Question: Provide a publication-style caption for this figure.
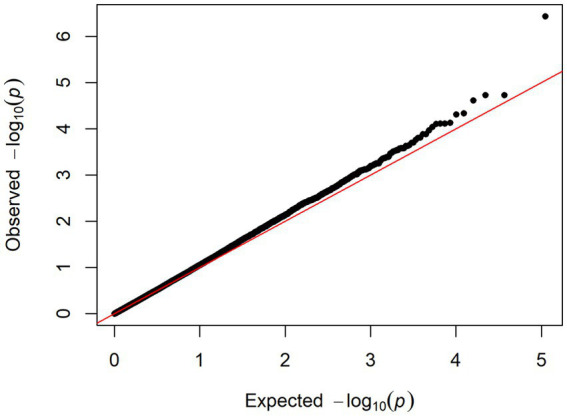
Answer: QQ plot of observed vs. expected p -values for cervicovaginal pH genome-wide association study of Dohne Merino ewes immediately post-CIDR, sponge, or control treatment.